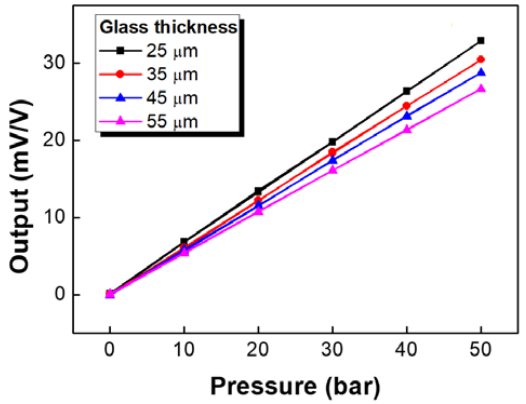
Figure 9. Wheatstone bridge output for Si strain gauges with various glass thicknesses.